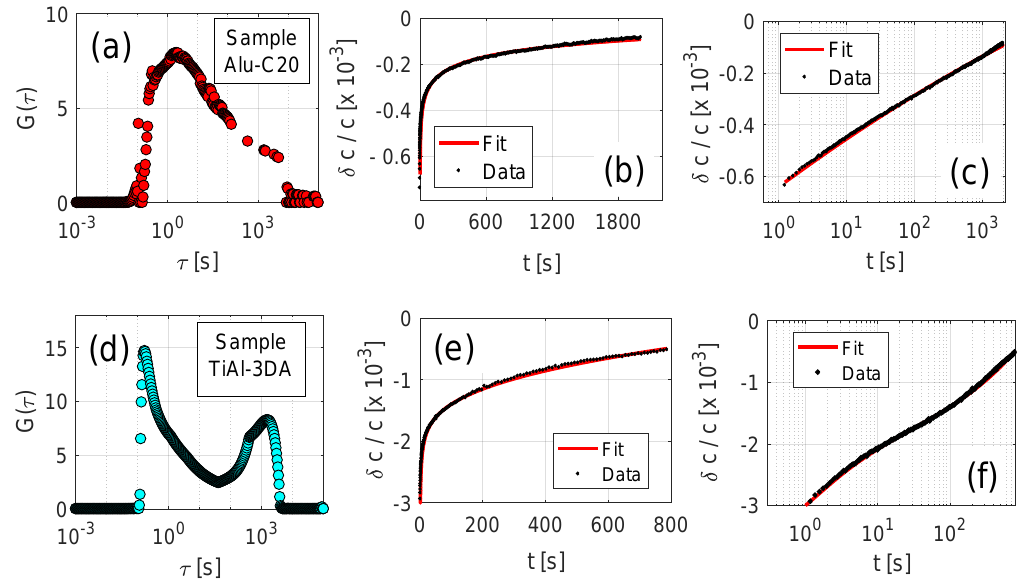
Figure 5. Multirelaxation process with decay times uniformly distributed in the log space. ( a , d ) Distribution of G i in the log 10 ( τ ) space for different choices of the basis range B 1 to B N and two different metal alloy samples (two rows). ( b , c , e , f ) Results of the fitting procedure for one specific choice ( K = 1) of the selected bases are also